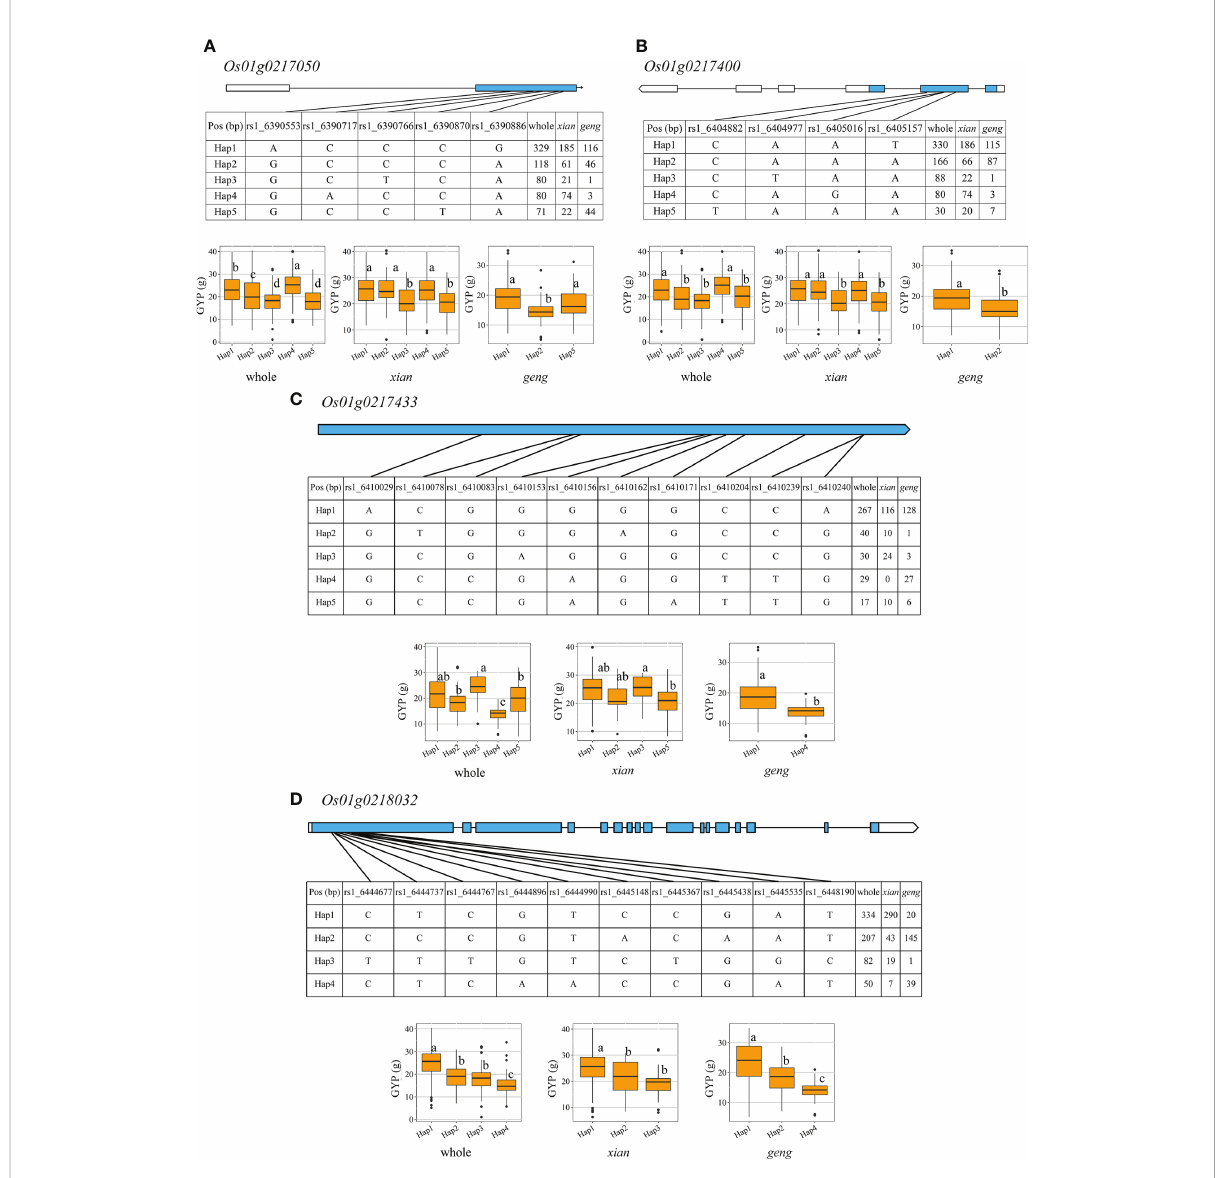
FIGURE 4 Exon-intron structure and haplotype analysis of four candidate genes in whole, xian and geng populations for qGYP1.2. (A) Os01g0217050 , (B) Os01g0217400 , (C) Os01g0217433 , (D) Os01g0218032 . Different letters indicate signi fi cant differences in trait values among haplotypes by Duncan ’ s test at p <